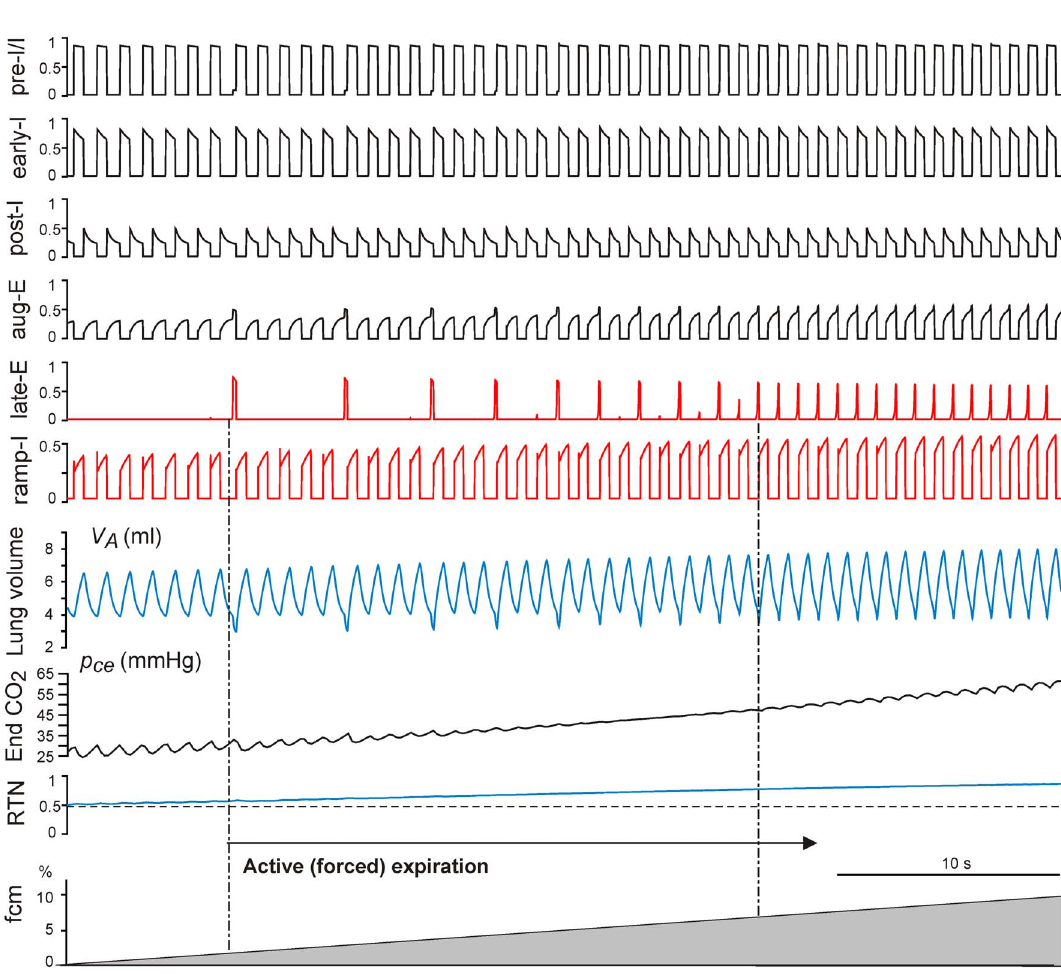
Figure 5. Simulation of progressive hypercapnia in the intact model. The continuous increase of hypercapnia (the grey ramp at the bottom) was induced by increasing CO 2 content in the mouth f cm from 0 to 10%. Active expiration starts with the first appearance of late-E discharges (indicated by the left vertical dot-dashed line at f cm =2.6%) and reaches the regime with a 1:1 ratio of late-E to ramp-I activations at f cm =7.2%. As described in the text, each late-E discharge, representing the activity of AbN output, actuates the abdominal pump that reduces the baseline level of lung volume (see in the V A trace). (Figure 5 and 7A) and at f cm = 7% in the vagotomized case (Figure 6 and 7B).